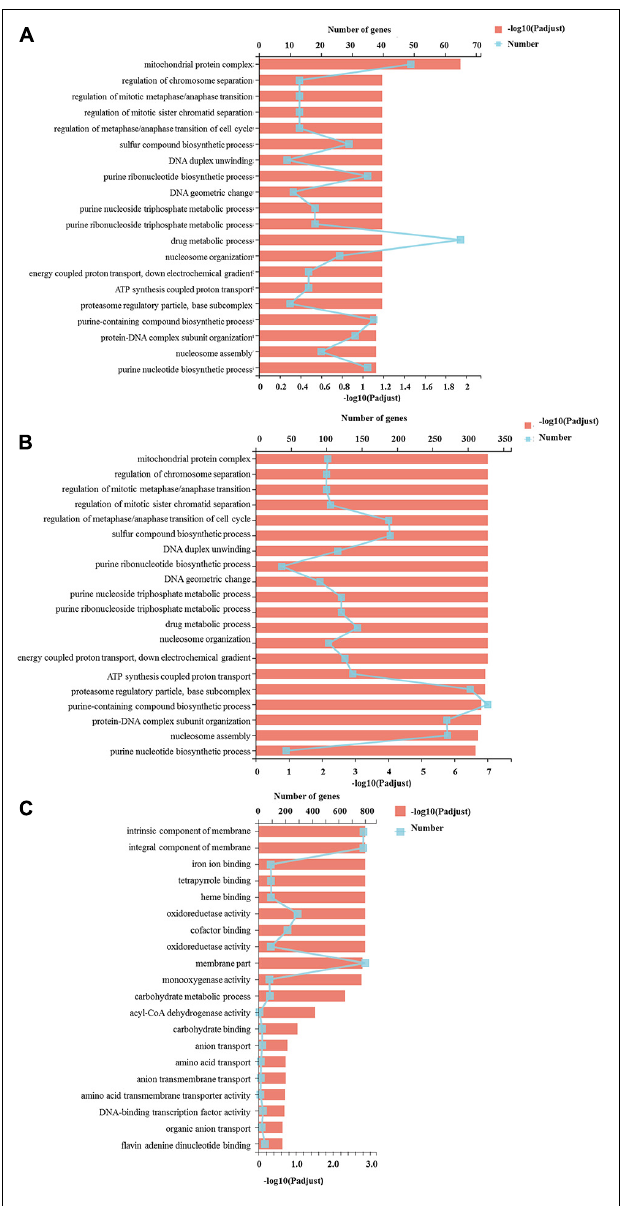
FIGURE 3 | GO functional classification of differentially expressed genes. The Y axis represents the GO terms, the upper X axis represents the number of DEGs assigned to GO terms, the basal X axis represents the p -adjusted value, the broken lines represent the number of DEGs in each GO term, and the bars represent the p -adjusted value. (A) The DEGs assigned to GO terms in the S vs. P comparison; (B) indicated the DEGs assigned to GO terms in the P vs. F comparison; (C) the DEGs assigned to GO terms in the S vs. F comparison.